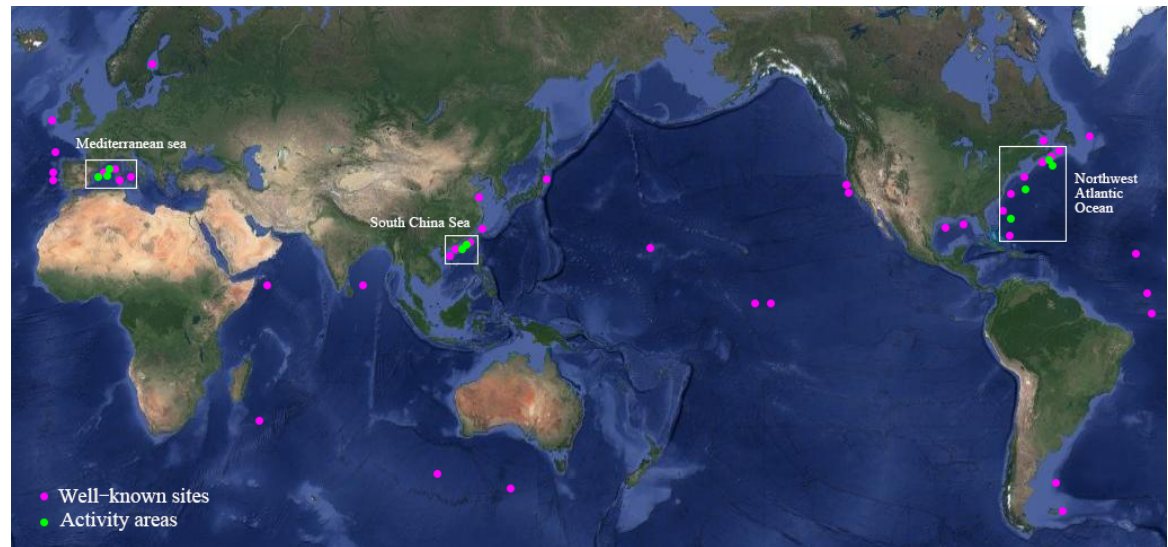
Figure 1. Global marine nepheloid layer distribution. Nepheloid layers observed from 1953 to 2019. Shown are well-known sites of occurrence (pink) and new areas of activity (green).